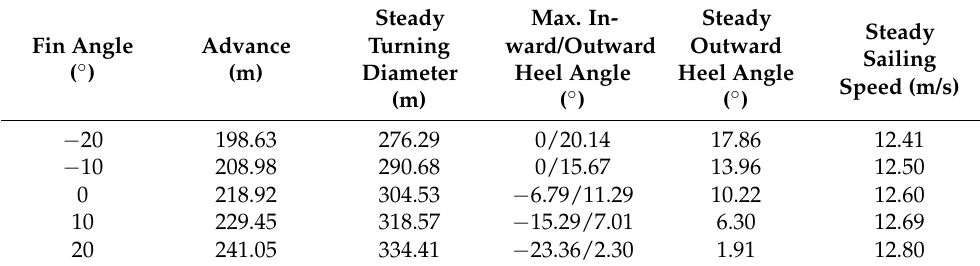
Figure 3. Simulation results of ship turning motion under different fin angles. ( a ) Trajectory; ( b ) ship speed; ( c ) roll angle; ( d ) roll rate. Table 4. Simulation results of turning circle parameters under different fin